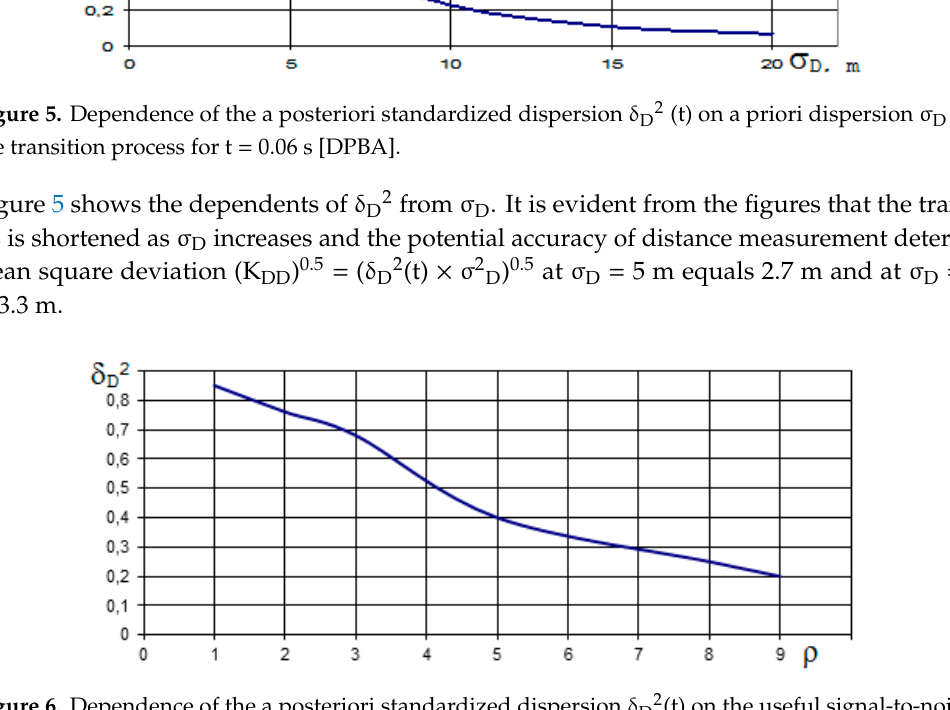
δ D2 (t) on a priori dispersion σ D in